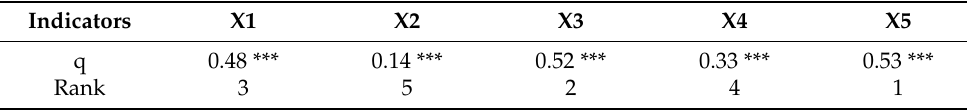
Table 6. Results of dominant factor detection.